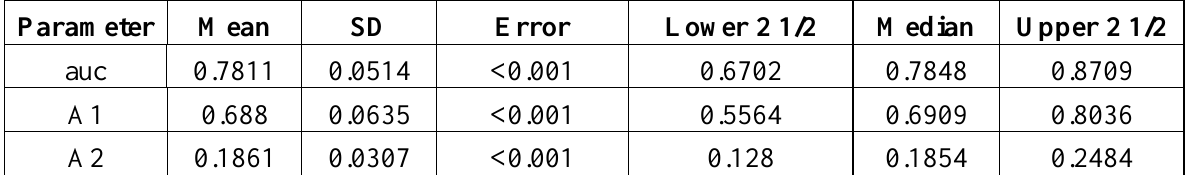
Table 8. Posterior distribution of area under the ROC